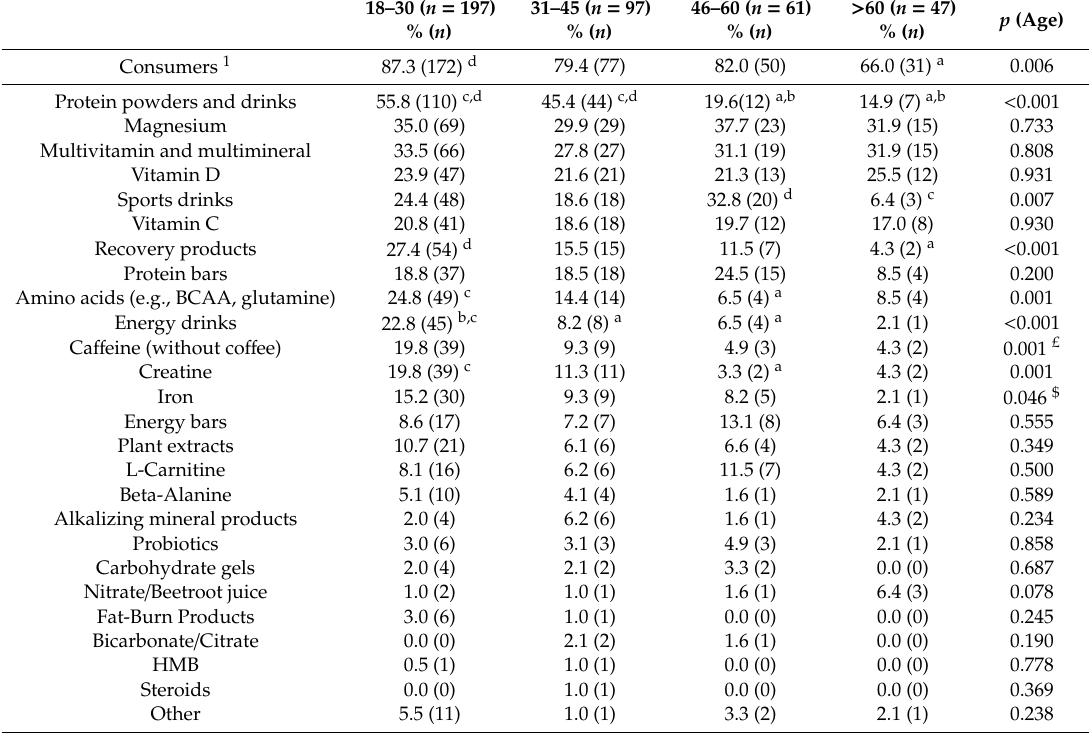
Table 3. Supplement intake prevalence by age